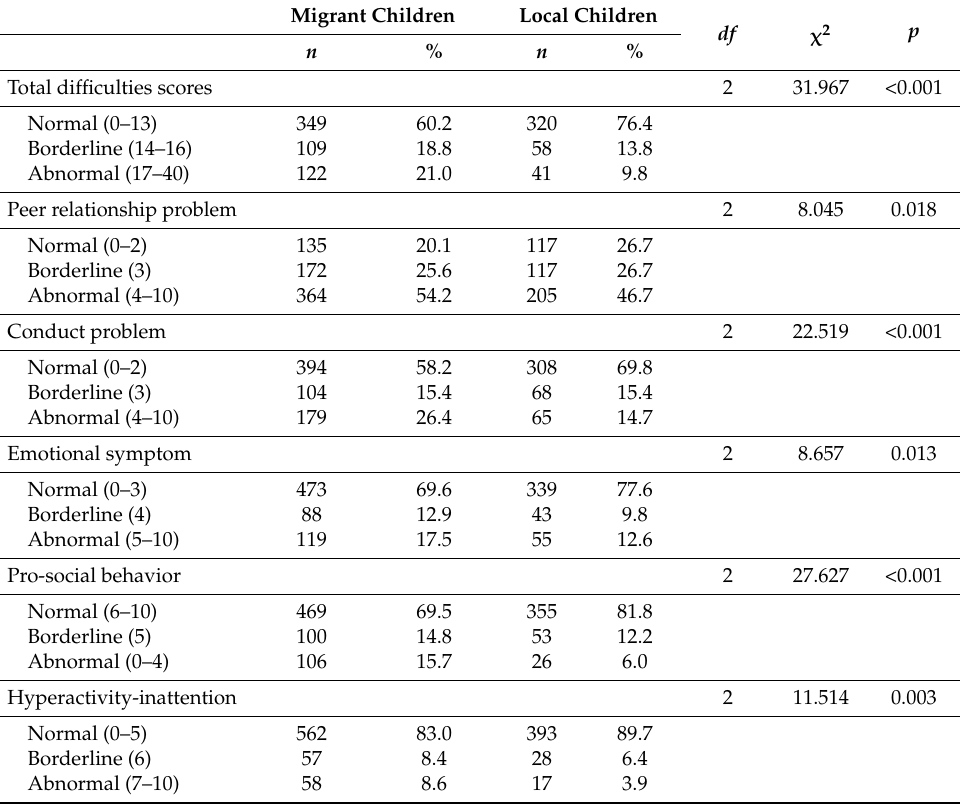
Table 2. Prevalence of mental health problems in the migrant and local children.